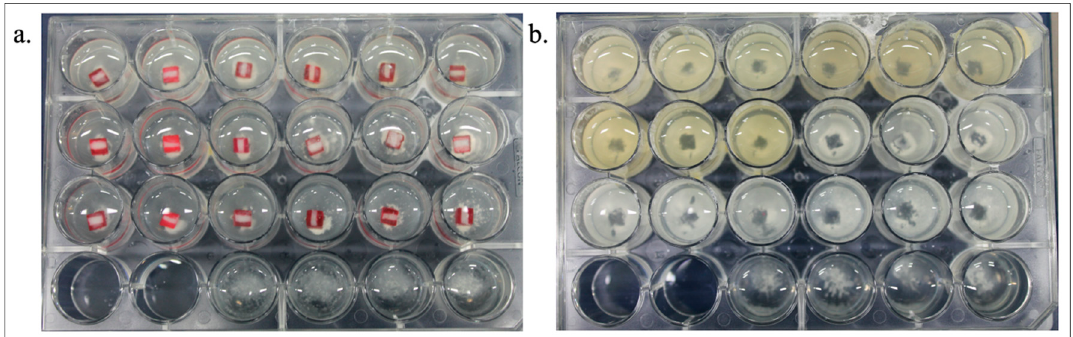
Figure 2. The image shows the 24-well microtiter plates during the experiment ( a ) and after the removal of enamel specimens, leaving a print in the biofilm ( b